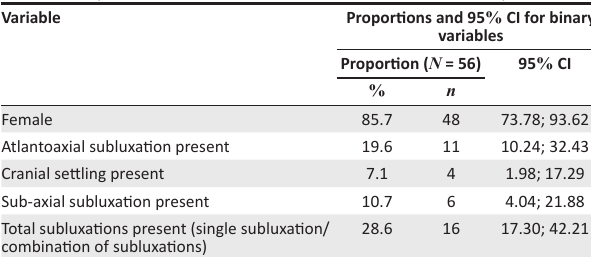
TABLE 2: Proportions, as well as 95 % confidence interval for binary variables. Variable Proportions and 95 % CI for binary